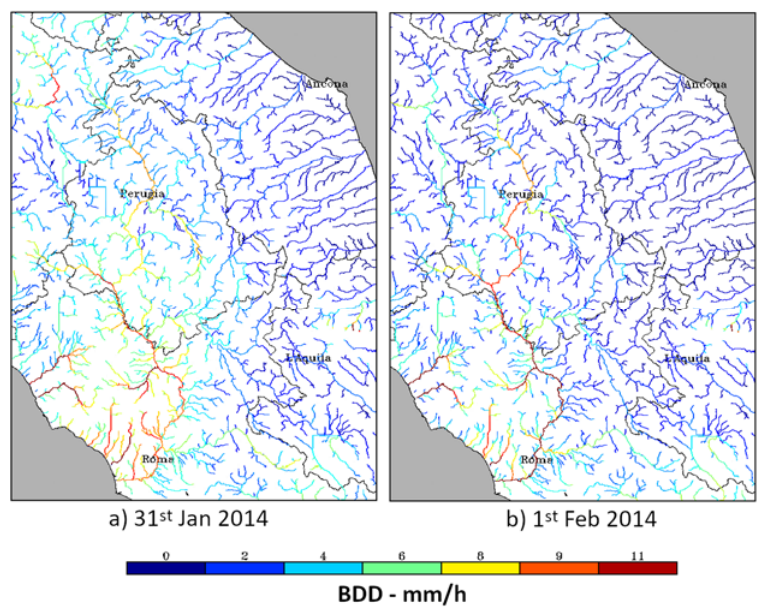
Figure 7. BDD index daily maps for relevant days of the weather event.